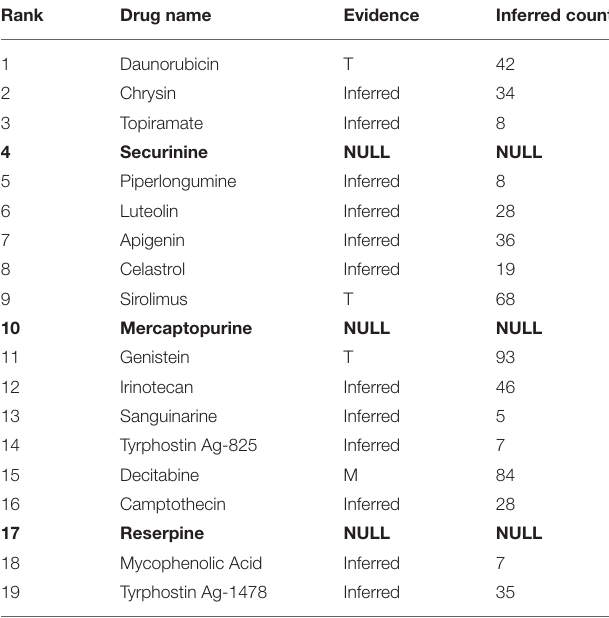
TABLE 2 | Nineteen therapeutic drugs for HCC in the Top-30